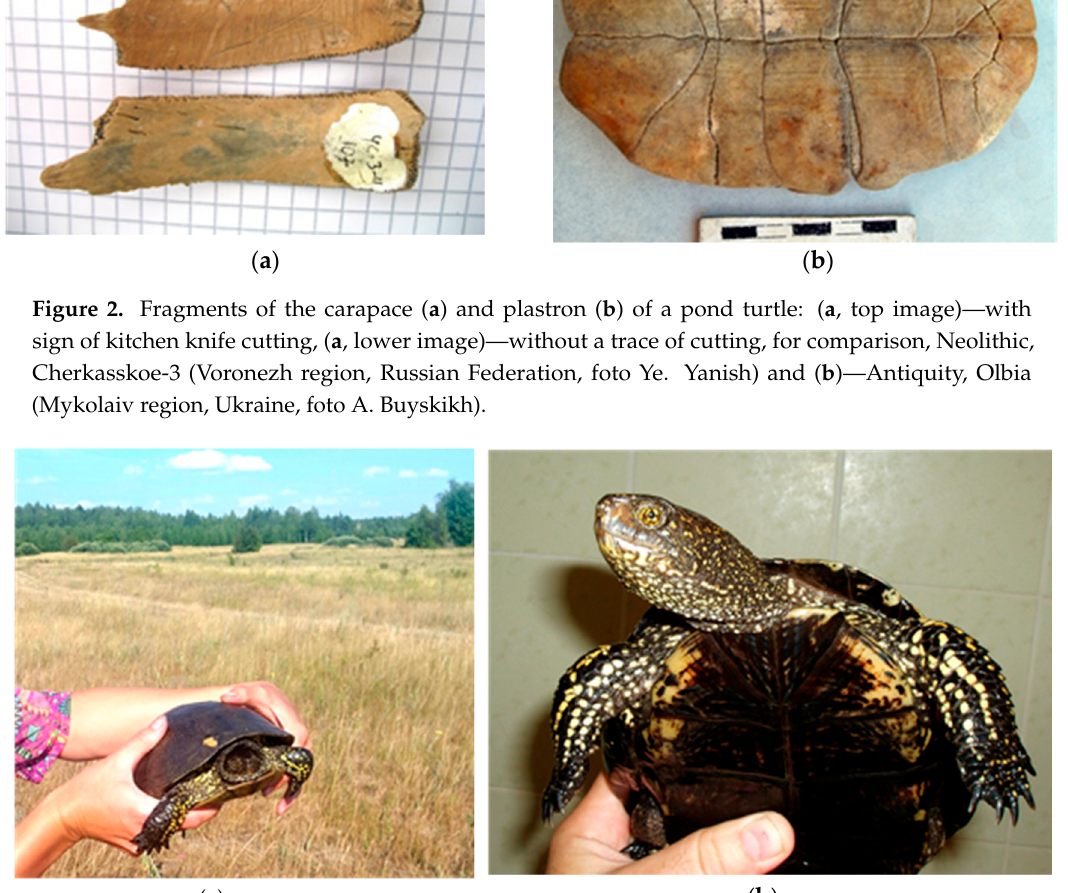
Figure 3. ( a )— E. orbicularis , was caught an near site of the Neolithic settlement Vasilievsky cordon-27 (located in a meadow nearby a forest). After five years of research nearby the Voronezh River this is the first record of the species here (foto A. Zheludkov, 2018). ( b )— E. orbicularis adult female caught in Ance, Ventspils novads, Latvia. This is one of European northernmost modern records of the species (foto M. Pupins, 2007).